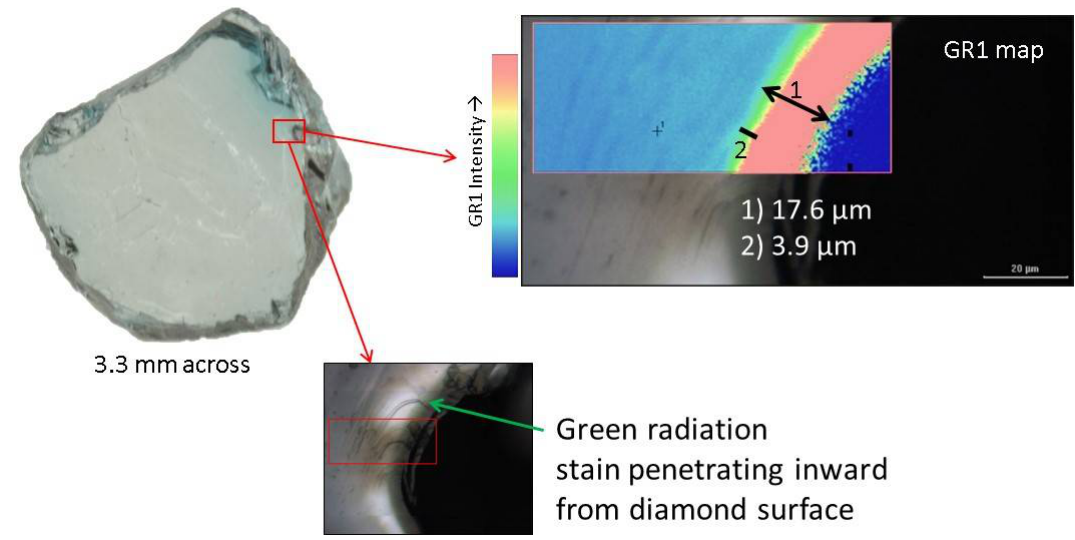
Figure 8. PL mapping of GR1 at the edge of a cleaved diamond sample with radiation damage shows that the structure of vacancy distribution at depth in the diamond is similar to that observed adjacent to surface stains.